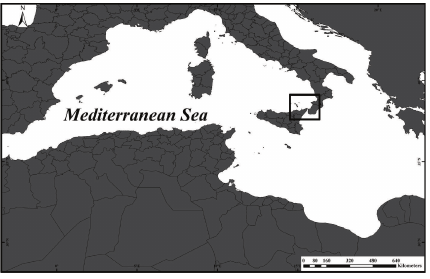
Figure 2: S. pachygaster captured in the Strait of Messina (Central Mediterranean Sea).